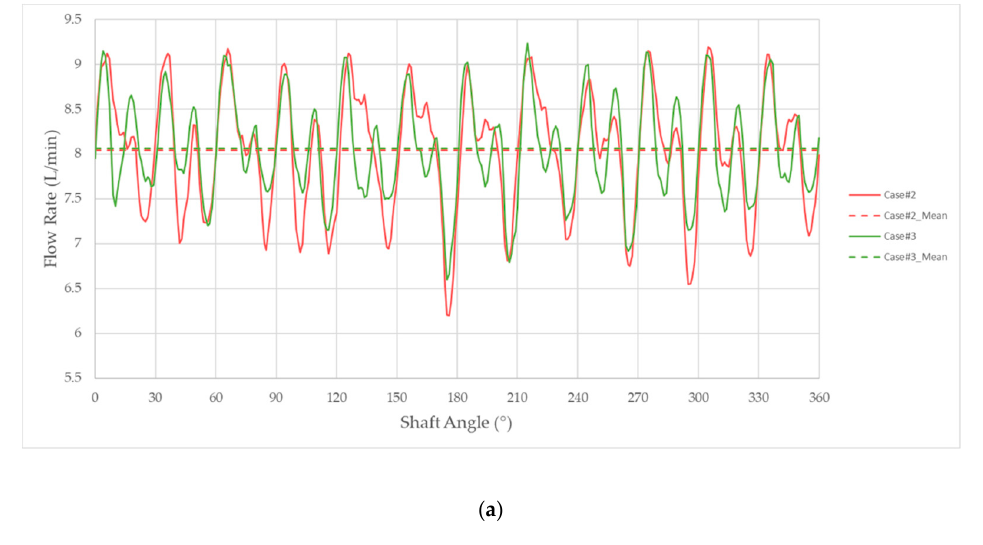
Table 8. Delivered flow rate and volumetric efficiency of the pump for three different fluids: min- eral oil, Total BIOHYDRAN TMP 46, and olive oil.